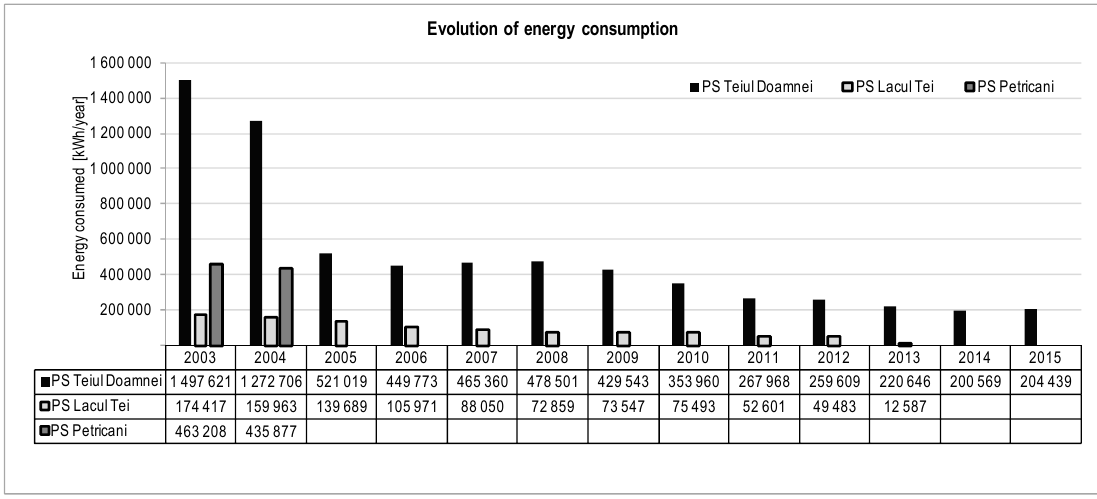
Figure 5. Evolution of energy consumption for the booster stations in Tei-Colentina